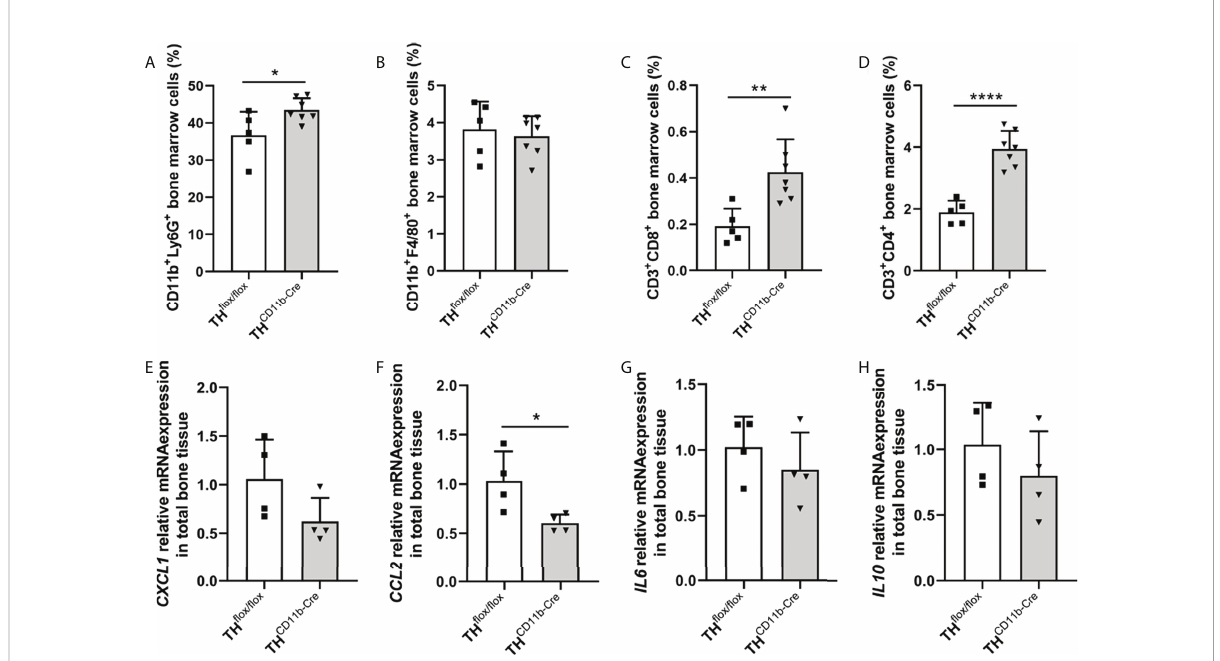
FIGURE 5 Immune phenotype of twelve-week-old TH CD11b-Cre mice. (A) CD11b + Ly6G + neutrophils, (B) CD11b + F4/80 + macrophages, (C) CD3 + CD8 + cytotoxic T lymphocytes and (D) CD3 + CD4 + T helper lymphocytes in the bone marrow of twelve-week-old TH fl ox/ fl ox and TH CD11b-Cre mice. (E) CXCL1 , (F) CCL2 , (G) IL6 and (H) IL10 relative mRNA expression in whole tibiae of twelve-week-old TH fl ox/ fl ox and TH CD11b-Cre mice. n = 4-7; *P < 0.05; **P < 0.01; ****P <